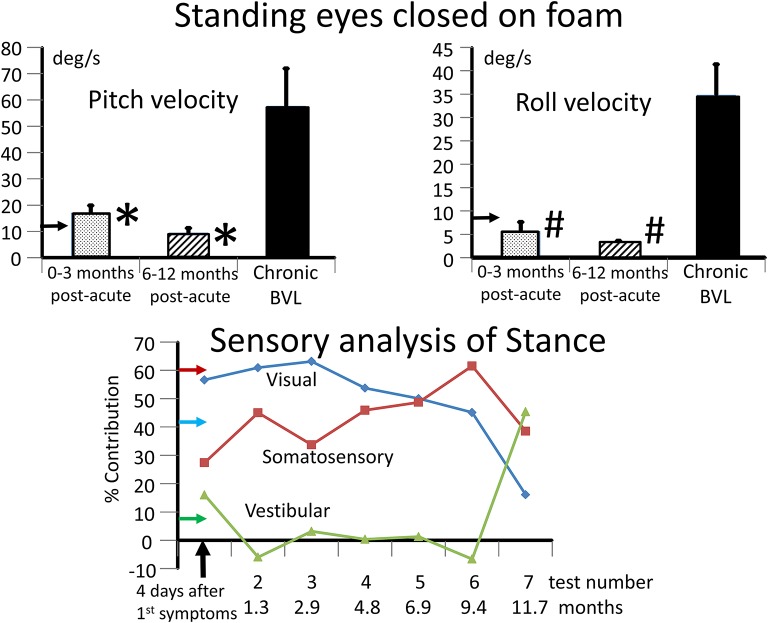
Upper panels: mean values and standard error of mean (sem) of BVL subjects for the range of trunk pitch and roll velocity while standing eyes closed on a foam surface. The leftmost column in each panel depicts the mean of 3 tests in the 3 months post-acute onset. The middle column in each panel depicts the mean of 3 tests in the 6–12 months period post-acute onset. The right column represents the mean values of the population of 8 chronic BVL subjects (mean age 44 years), all of whom had velocity values >95% upper limit of 54 normals of mean age 49. This limit, 11 deg/s for pitch and 8.4 deg/s for roll velocity, is shown by the horizontal arrows on the plot ordinates. The bars on the columns represent the sems. *p < 0.03 for the comparison of acute to chronic BVL pitch velocity means. #p < 0.003 for the comparison of roll velocity means. Lower panel: sensory analysis of stance profile over the 12 months follow-up of the acute BVL subject. The estimated contribution of each sensory input to pitch sway was computed using the technique of Horlings et al. (9). For example, for the 4 2-legged stance test conditions normal floor eyes open and closed (s2eo, s2ec) and foam support eyes open and closed (s2eof, s2ecf) the visual contribution is estimated to be:((s2ecf-s2eof) + (s2ec-s2eo))/(s2ecf+s2eof+s2ec+s2eo)*100%.The somatosensory contribution is estimated to be:((s2ecf-s2ec) + (s2eof-s2eo))/(s2ecf+s2eof+s2ec+s2eo)*100%.The vestibular contribution is estimated to be 100% minus the visual and somatosensory contributions. The 95% upper limit for visual and somatosensory contribution estimates with respect to healthy controls are shown by the horizontal arrows on the ordinate (larger values pathological), likewise the lower normal 5% limit (smaller values pathological) for the vestibular contribution. Thus, the visual and somatosensory contributions were pathologically greater than normal from 1.3 to 11.7 months and therefore the vestibular contribution less than normal over this period.